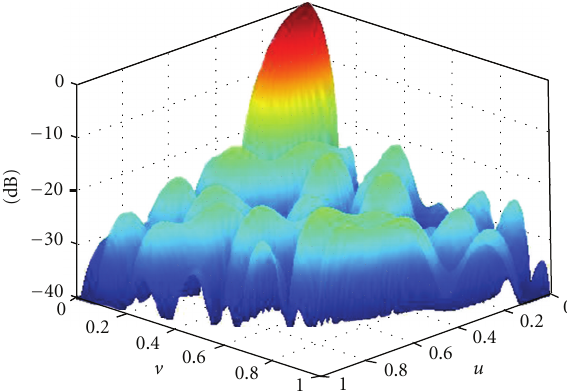
Figure 4: Three dimension radiation pattern of the optimized array for reduction PSLL in all ϕ